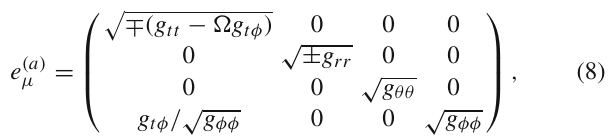
r ± (with r + ≥ r − ) corresponding to Cauchy ( r − ) and event ( r + ) horizons. Further, analysis of the zeros of (cid:14) = 0